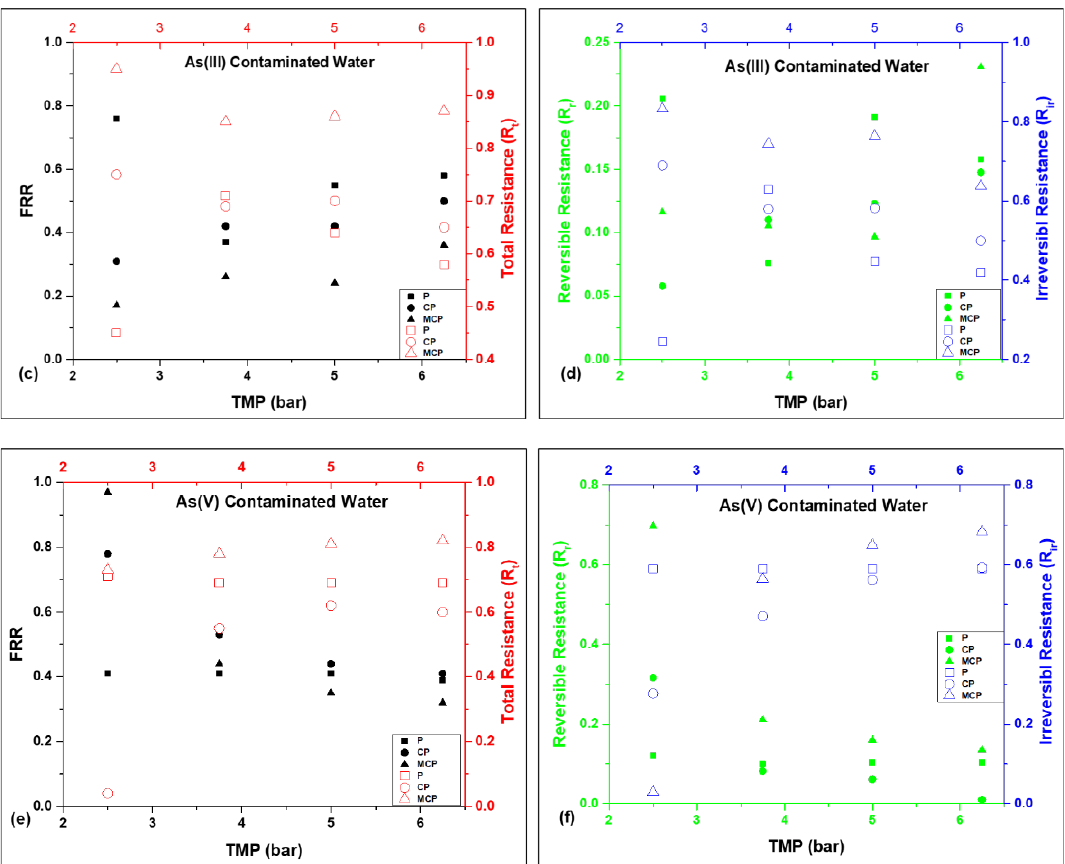
Figure 3. ( a , c , e ) Fouling recovery ratio and total fouling resistance of the membranes as a function of TMP in terms of pure and arsenic-contaminated water, and ( b , d , f ) reversible and irreversible resistance of the membranes as a function of TMP in terms of pure and arsenic-contaminated water.